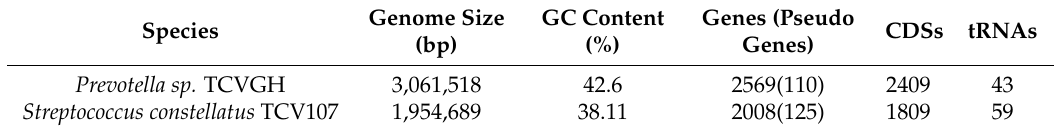
Figure 3. Circular genome map of Prevotella sp. TCVGH ( a ) and Streptococcus constellatus TCV107 ( b ). Circular genome maps. From outer to inner circles: genes on forward strand, genes on reverse strand, rRNA, GC content and GC skew. ( a ) Circular genome map of Prevotella sp. TCVGH; ( b ) Circular genome map of Streptococcus constellatus TCV107. The innermost circle shows strong and opposite GC skews in the leading and lagging strands, partitioning the genome into two halves separated by replication origin ( ori ) and terminus ( ter ) sequences. The two outer circles exhibit strong gene orientation bias, whereas half genes are dominantly on the forward strand and the other half are on the reverse strand, partitioned by ter and ori . Table 1. Genomic data of Prevotella sp. TCVGH and Streptococcus constellatus TCV107.